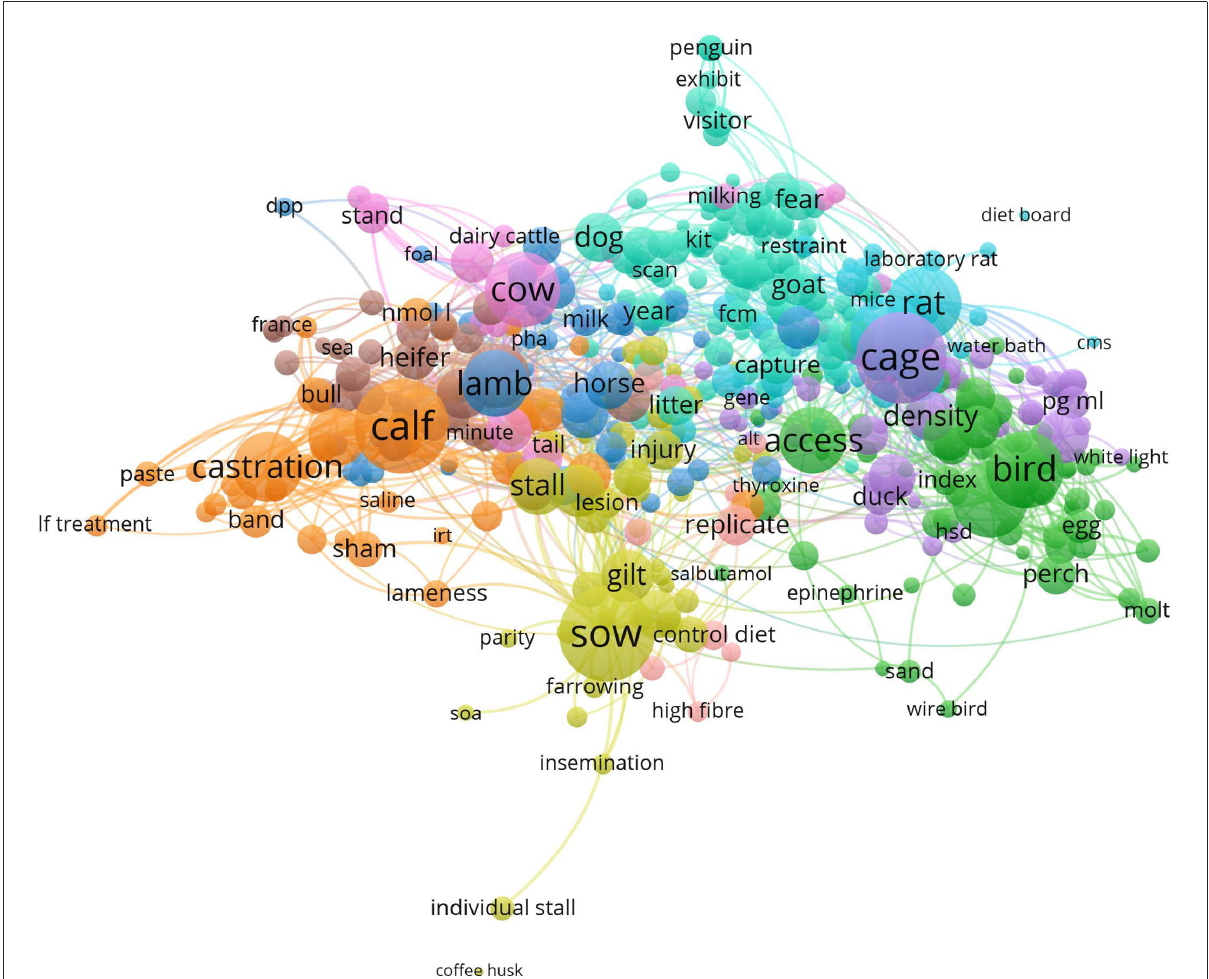
FIGURE2 VOSviewer visualization of the abstract co-occurrence network based on the 509 studies included in this mapping review. Clusters are indicated by the same color. The frequency of occurrence of terms is reflected by the size of the circles. The distance between the circles reflects their relatedness based on the co-occurrence of the terms, which means the shorter the distance, the stronger the